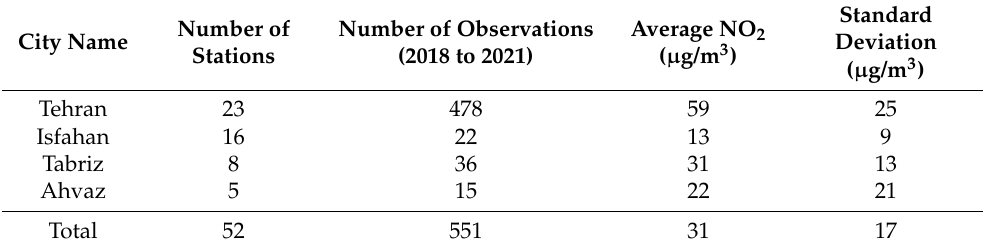
Table 2. Statistics of validation